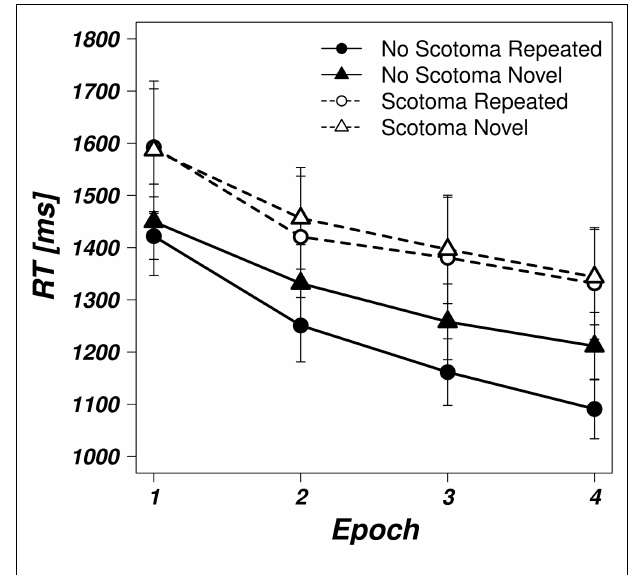
FIGURE 2 |Averaged search times in the visual search task for the unimpaired (solid, filled symbols) and scotoma (dashed, open symbols) viewing conditions for repeated (circles) and novel (triangles) displays as a function of epoch. Error bars represent the standard error of the